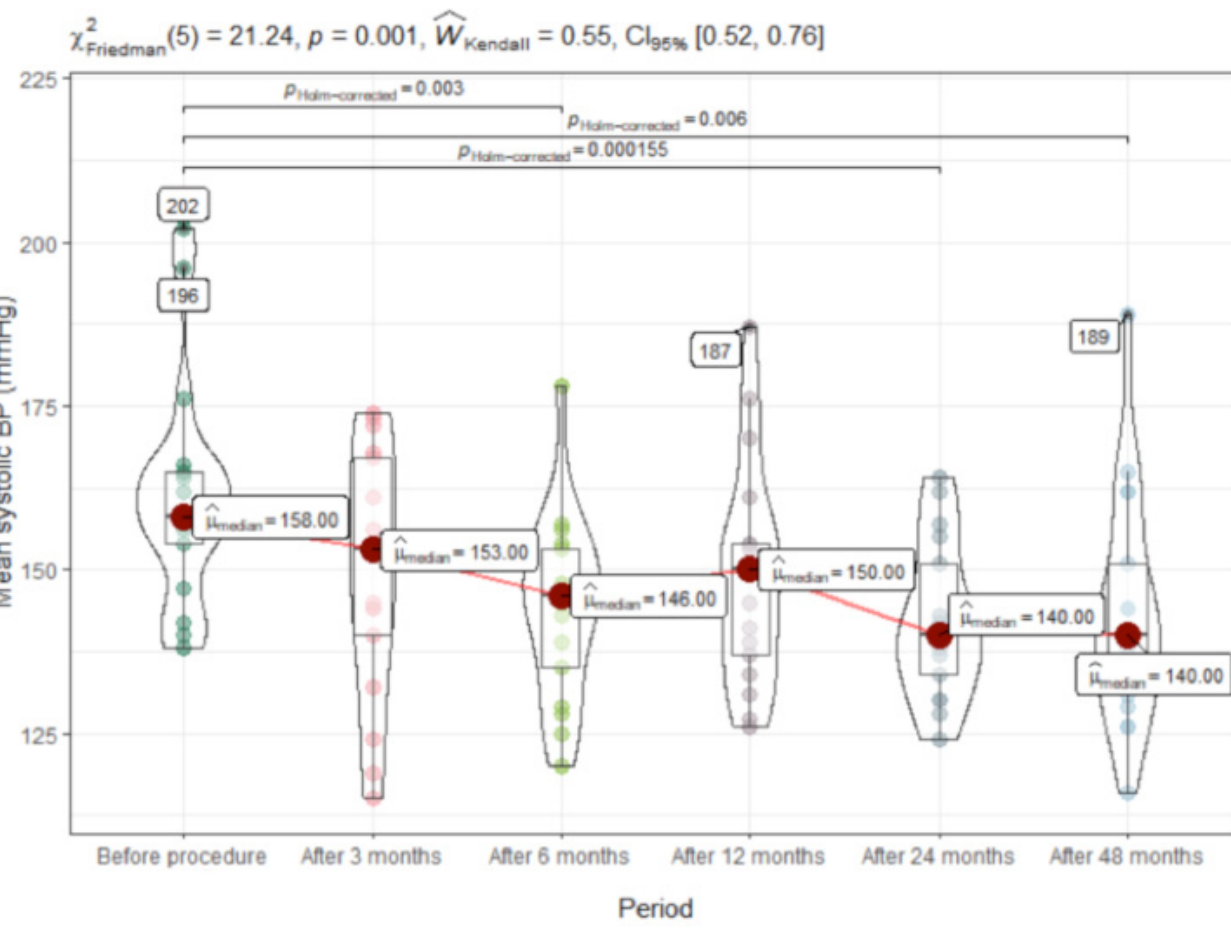
Figure 2. Mean systolic 24 h ambulatory BP after RDN (mmHg).